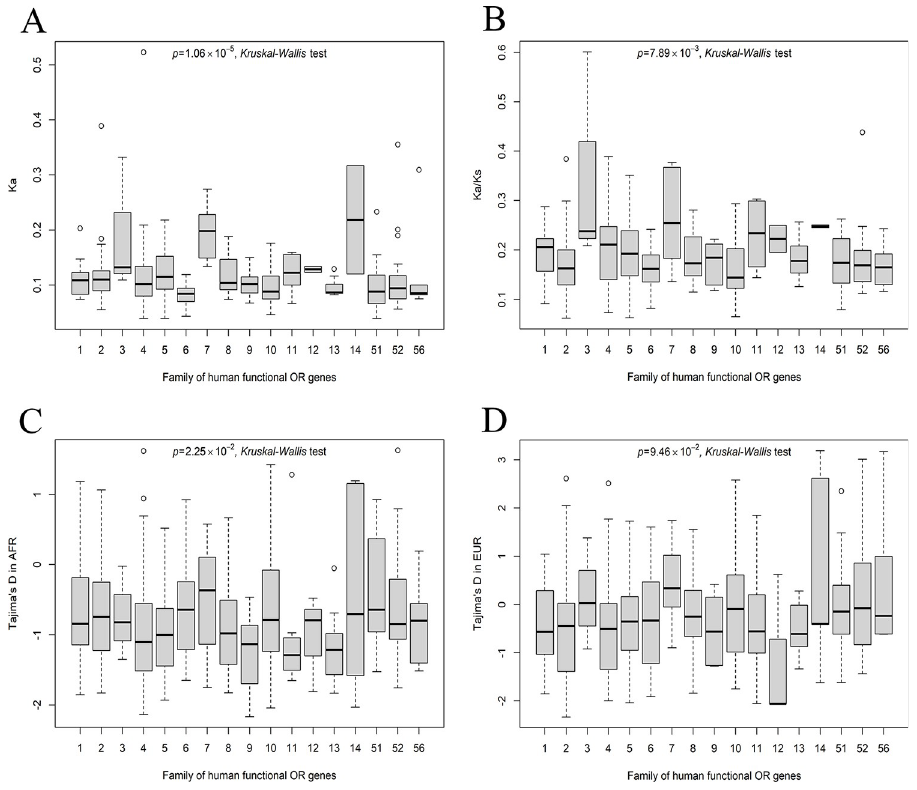
Fig 3. Different evolutionary rates and selection patterns among families of human functional OR genes. (A) Comparison of Ka. (B) Comparisons of Ka/Ks. (C) Comparisons of Tajima’s D in AFR. (D) Comparison of Tajima’s D in EUR.